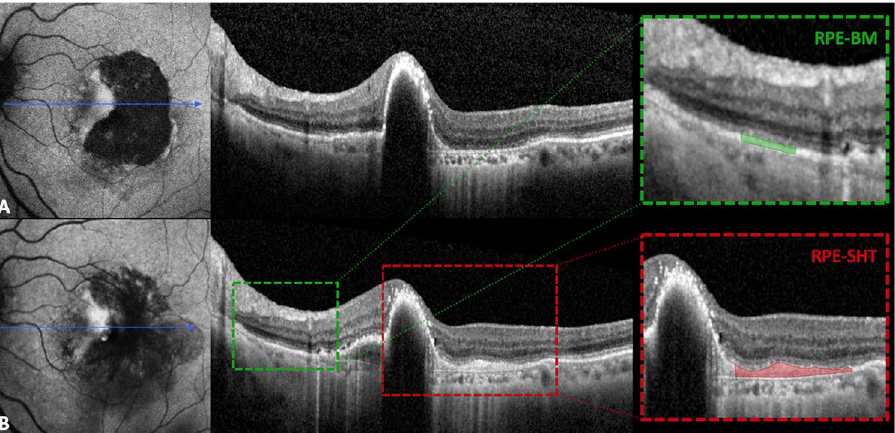
Figure 2. Measurement of repair tissue reflectivity following retinal pigment epithelial (RPE) tear by means of spectral-domain optical coherence tomography (SD-OCT). ( A ) and ( B ) show blue-light autofluorescence and SD-OCT scans of a patient at baseline and at 12 months of follow-up, respectively. Red dashed box highlights the formation of the RPE-subretinal hyperreflective tissue complex that was quantitatively measured after manual delineation. RPE-Bruch’s membrane complex, used as internal reference, is presented in the green dashed